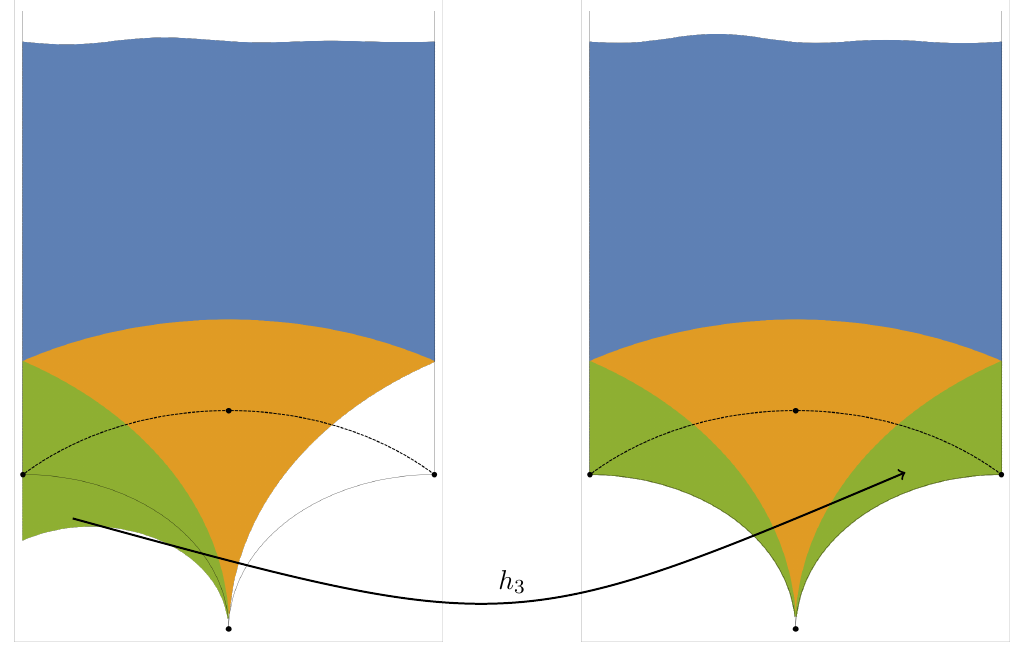
Figure 8 . Constructing a F 2 -symmetric fundamental domain for Γ 0 (2)